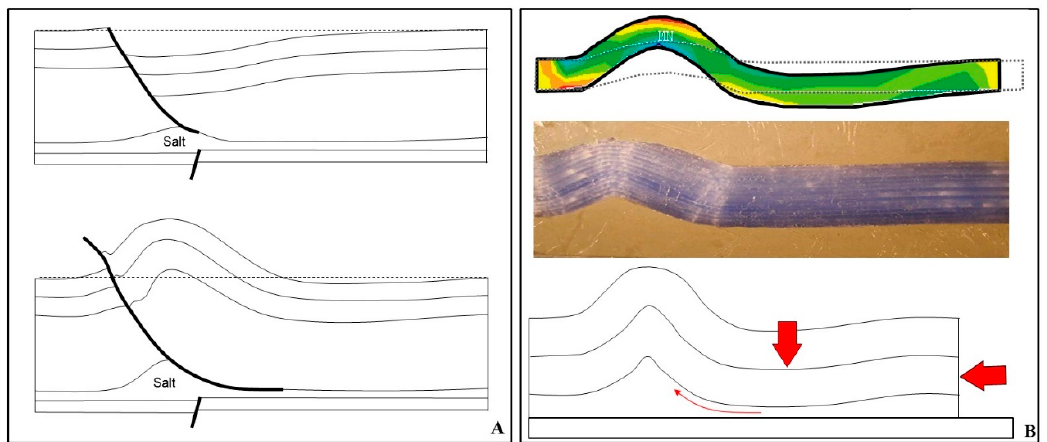
Figure 14. Two possible scenarios of the development of hanging wall synclines, as seen along the Nahdah and Qusaibah areas. ( A ) these synclines developed as drag folds along extensional faults that formed during the Late Cretaceous and were inverted during Late Cenozoic. This model might also explain the formation of the flanking folds that verge away from the main fold axes, as seen in the Salakh E and Hinaydil structures. ( B ) These synclines are a result of buckling caused by the Cenozoic shortening. The numerical modelling in ANSYSED was produced with about 1.5 km shortening. The other side of the layer is fixed in both X and Y directions. The formation of the anticline as a result of buckling is accompanied by a wide syncline in the moving part. The sandbox model in the middle shows an example of wide synclines developing in the hinterland due to fold buckling. The schematic diagram shows the mechanism of salt migration from the area underlying the syncline towards the anticlinal